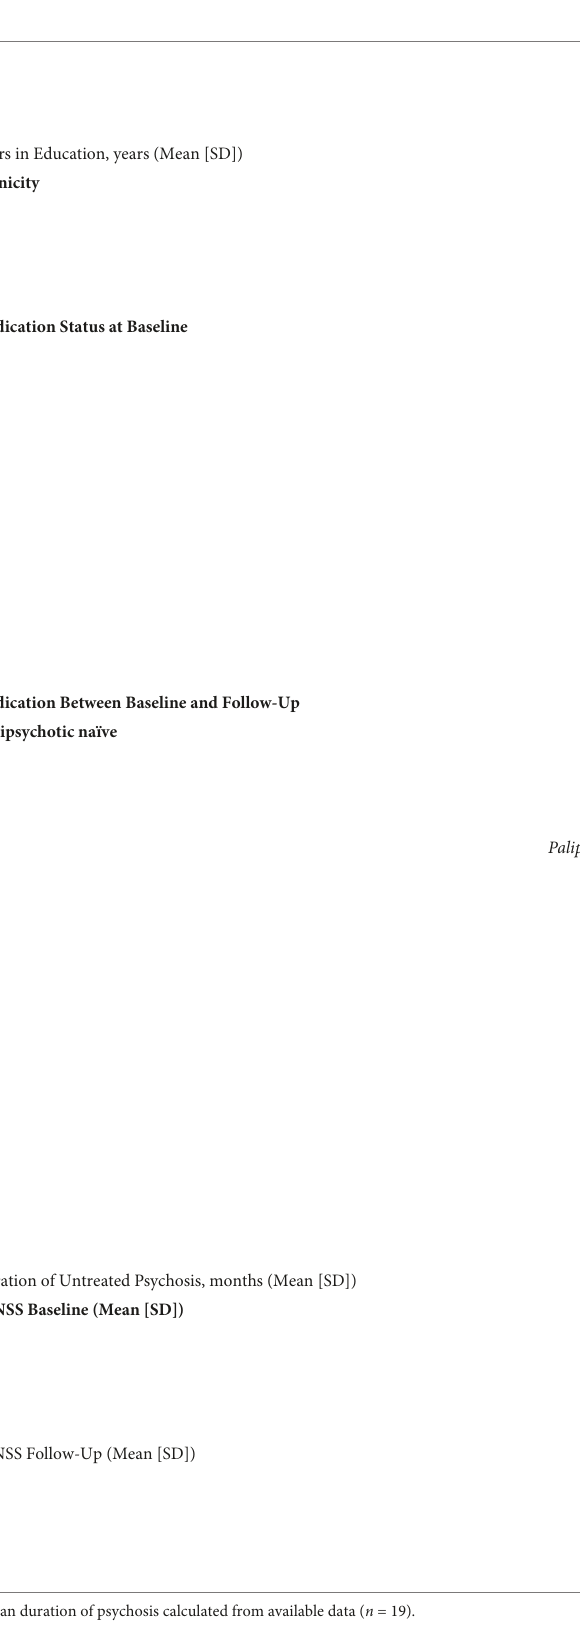
TABLE 1 Socio-demographic and clinical characteristics of